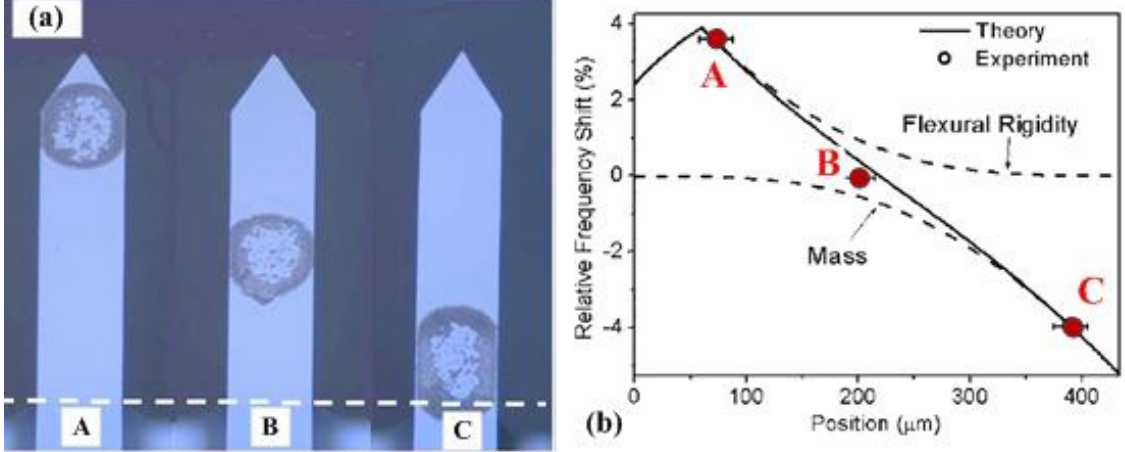
Figure 17. ( a ) Optical micrographs of three silicon cantilevers in which bacteria deposited near the free end (A), on the middle (B), and near the clamping (C) at three different positions; ( b ) Resonant frequency shift as a function of the longitudinal position of the adsorbed bacteria with respect to the clamping. Reused with permission from